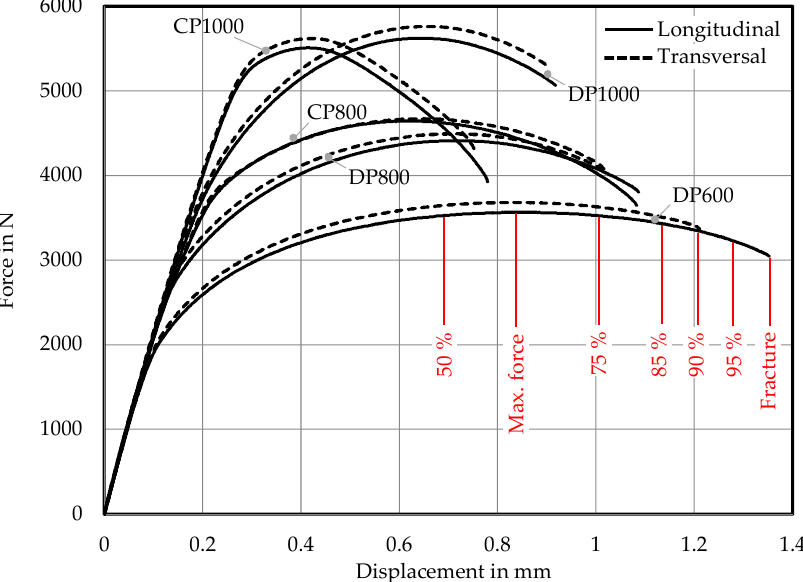
Figure 7. Force–displacement diagram of notched tensile tests; Red lines indicate discrete levels of stopped tests for the example of DP600.